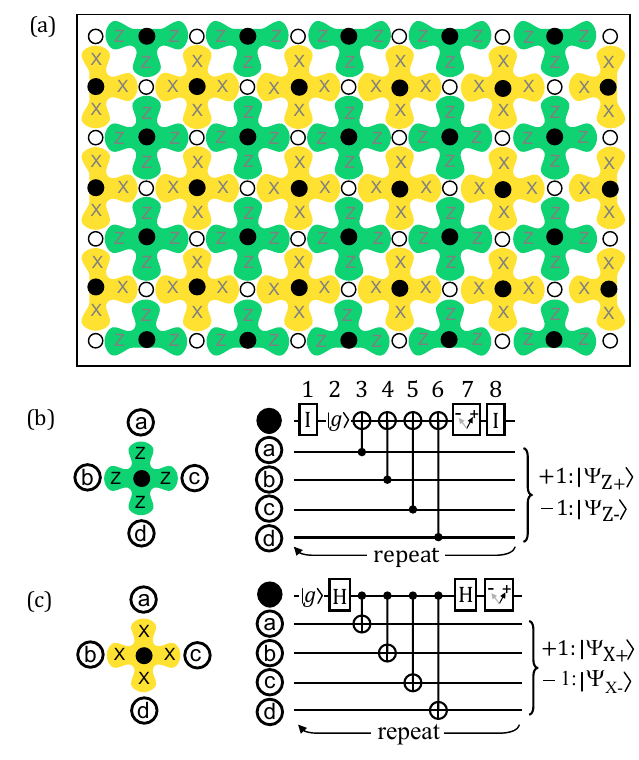
◦ ), measurement qubits are